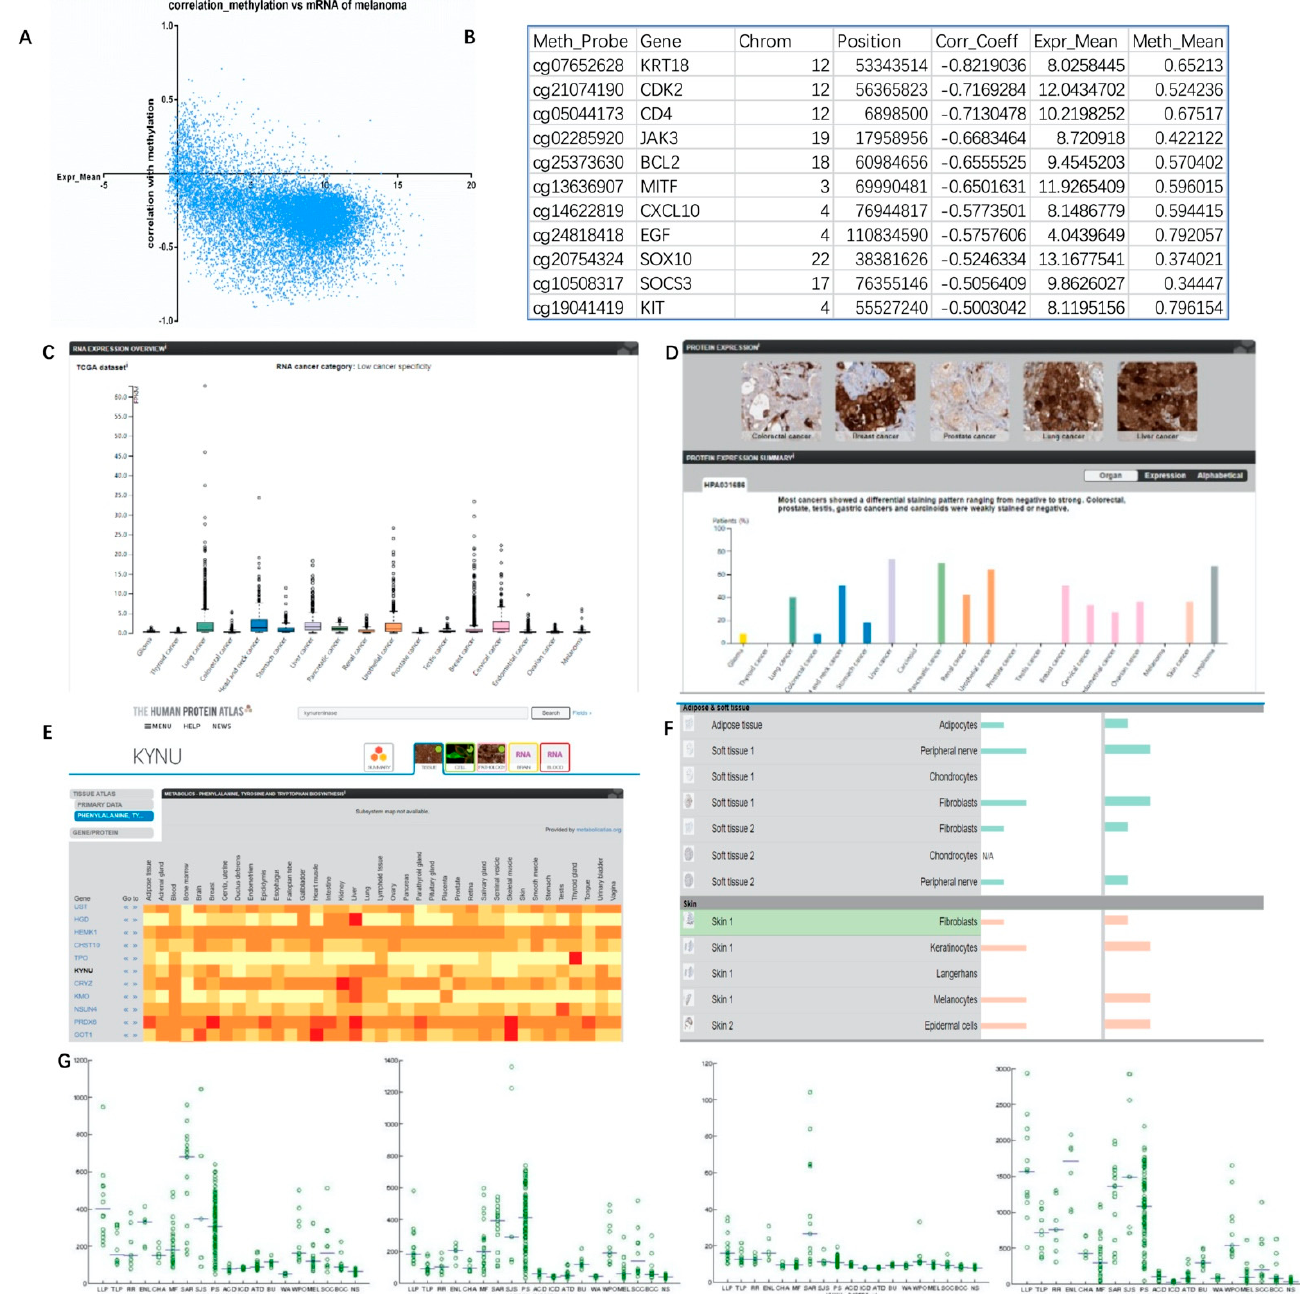
Figure 3. Levels of melanoma methylation indicating why KYNU could be a melanoma target: ( A , B ) GDCA broad institute analysis of the distribution of gene mRNA levels and DNA methylation as- sociations in TCGA database melanoma; ( C ) mRNA levels of KYNU in different tumors from TCGA database; ( D ) protein level and immunohistochemical staining of KYNU in different tumors from TCGA database; ( E ) heatmap of protein expression of KYNU in different tissues; ( F ) relative expres- sion distribution of KYNU in different kinds of skin cells; ( G ) expression distribution of KYNU in different probes/samples in meta-analysis of skin diseases.